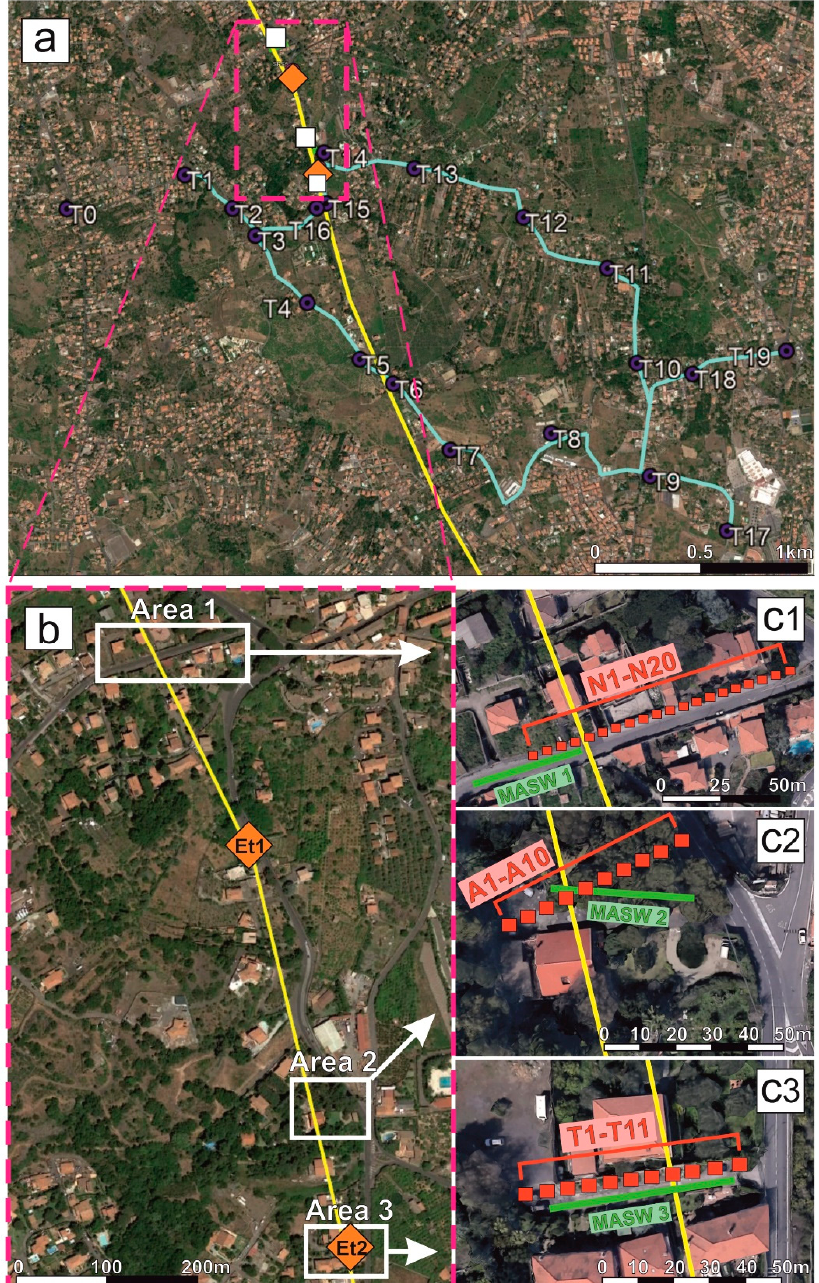
Figure 2. ( a ) Map of the levelling route (sky-blue line) across the Trecastagni Fault (TF). Blue circles indicate the levelling benchmarks; orange diamonds indicate the position of the extensometers. White squares indicate the location of seismic surveys. ( b ) Yellow line indicates the TF, and the extensometers are shown by orange diamonds (Et1, Et2). White rectangles (Area 1, Area 2 and Area 3) indicate the position of the geophysical surveys in the three different areas. ( c1 – c3 ) Red squares show the location of the sampling points of the noise, while the alignments of the MASW surveys are shown in green.